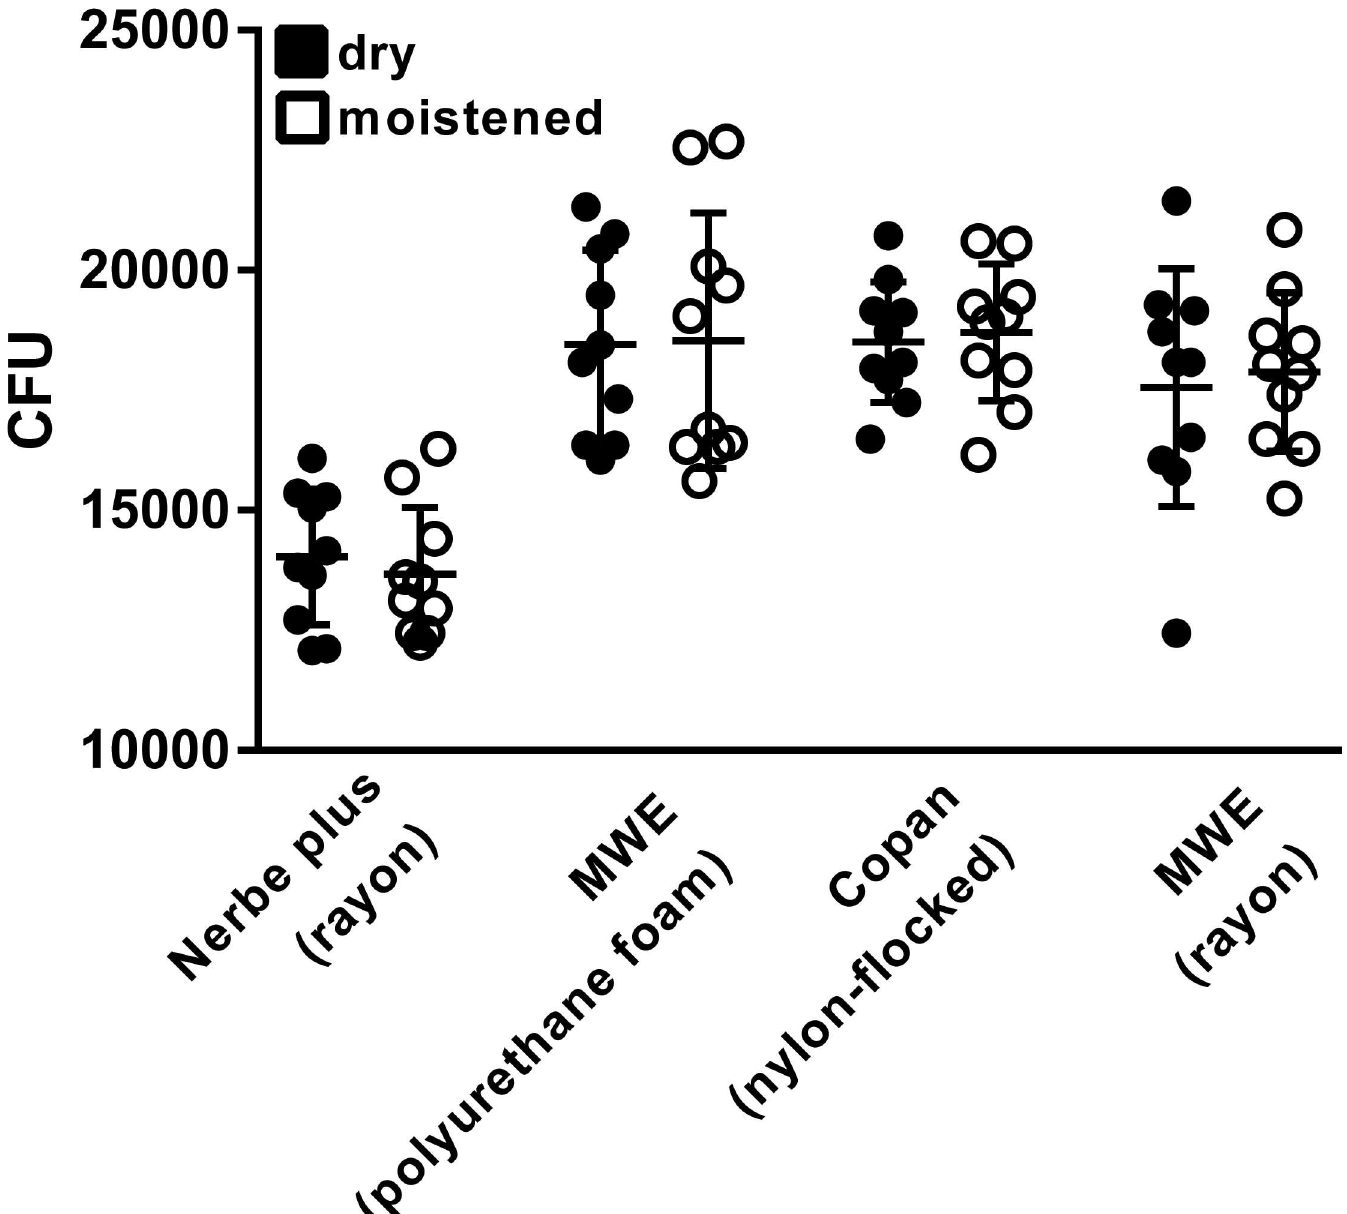
Fig 2. Recovered MRSA quantitiesfrom the artificialnose modelutilizingdry or moistrayon, polyurethane foam and nylon-flocked swabs. Nose modelswere swabbed utilizing eitherdryor moistenedrayon, polyurethane foam or nylon-flocked swabs. Data resultsfromn = 10 swabs for each setting. p-value (comparingdryand moistswabs withinone swab-type) = 0.62 (Nerbeplus, rayon); 0.90 (MWE,polyurethane); 0.72 (Copan,nylon-flocked); 0.96 (MWE,rayon) (Wilcoxon-Mann-Whitney U-test).